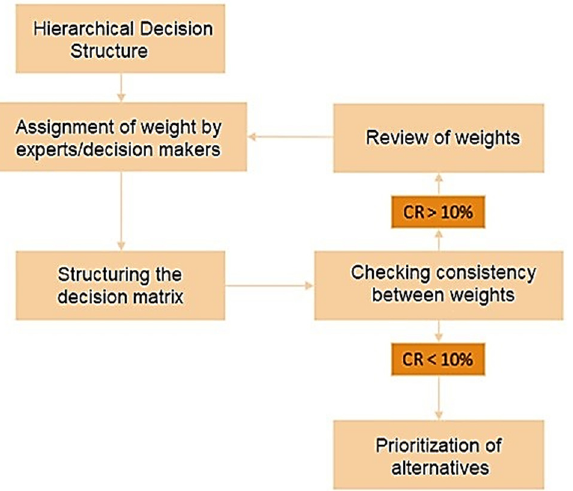
Figure 4. Flowchart for application of the AHP method, CR—consistency ratio. Adapted from Saaty [30].